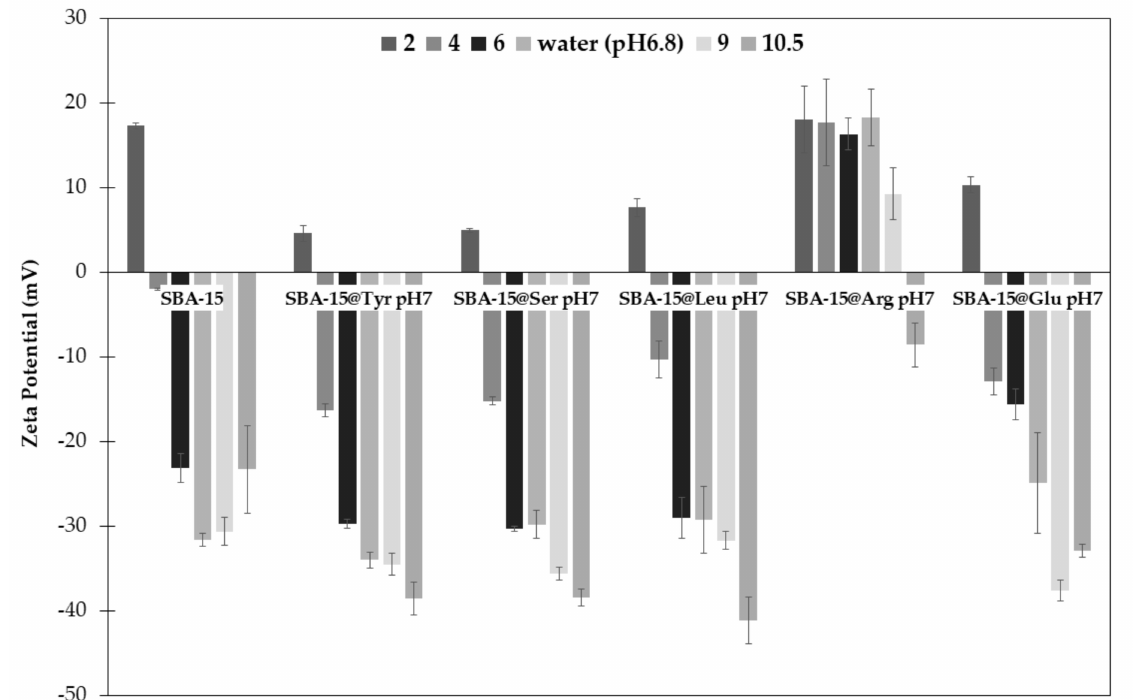
Figure 11. Zeta potential of bare SBA-15 and the SBA-15@AA samples as a function of pH. Measurements were performed at 25 ◦ C and at a concentration of 0.24